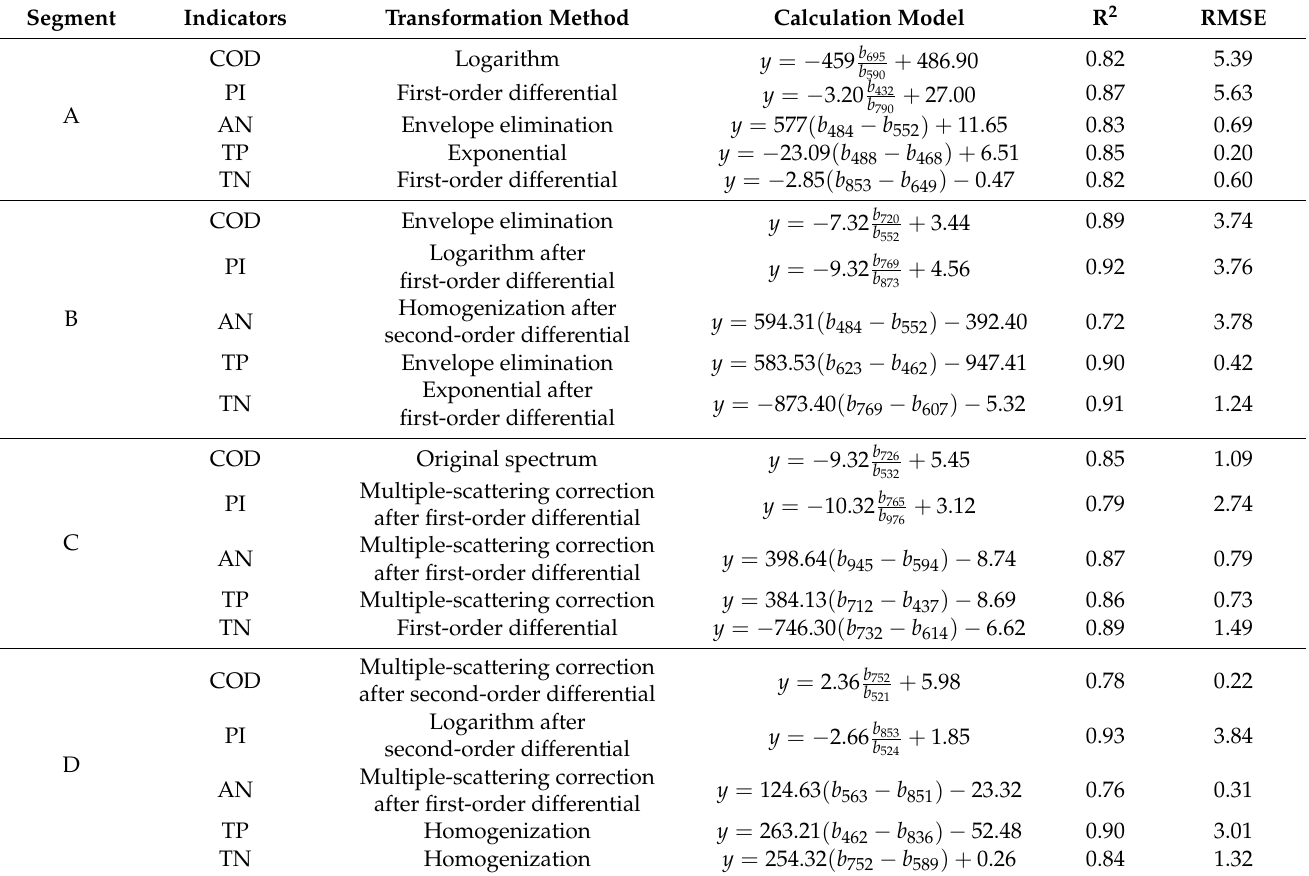
Table 3. Calculation model and precision evaluation results of water quality key